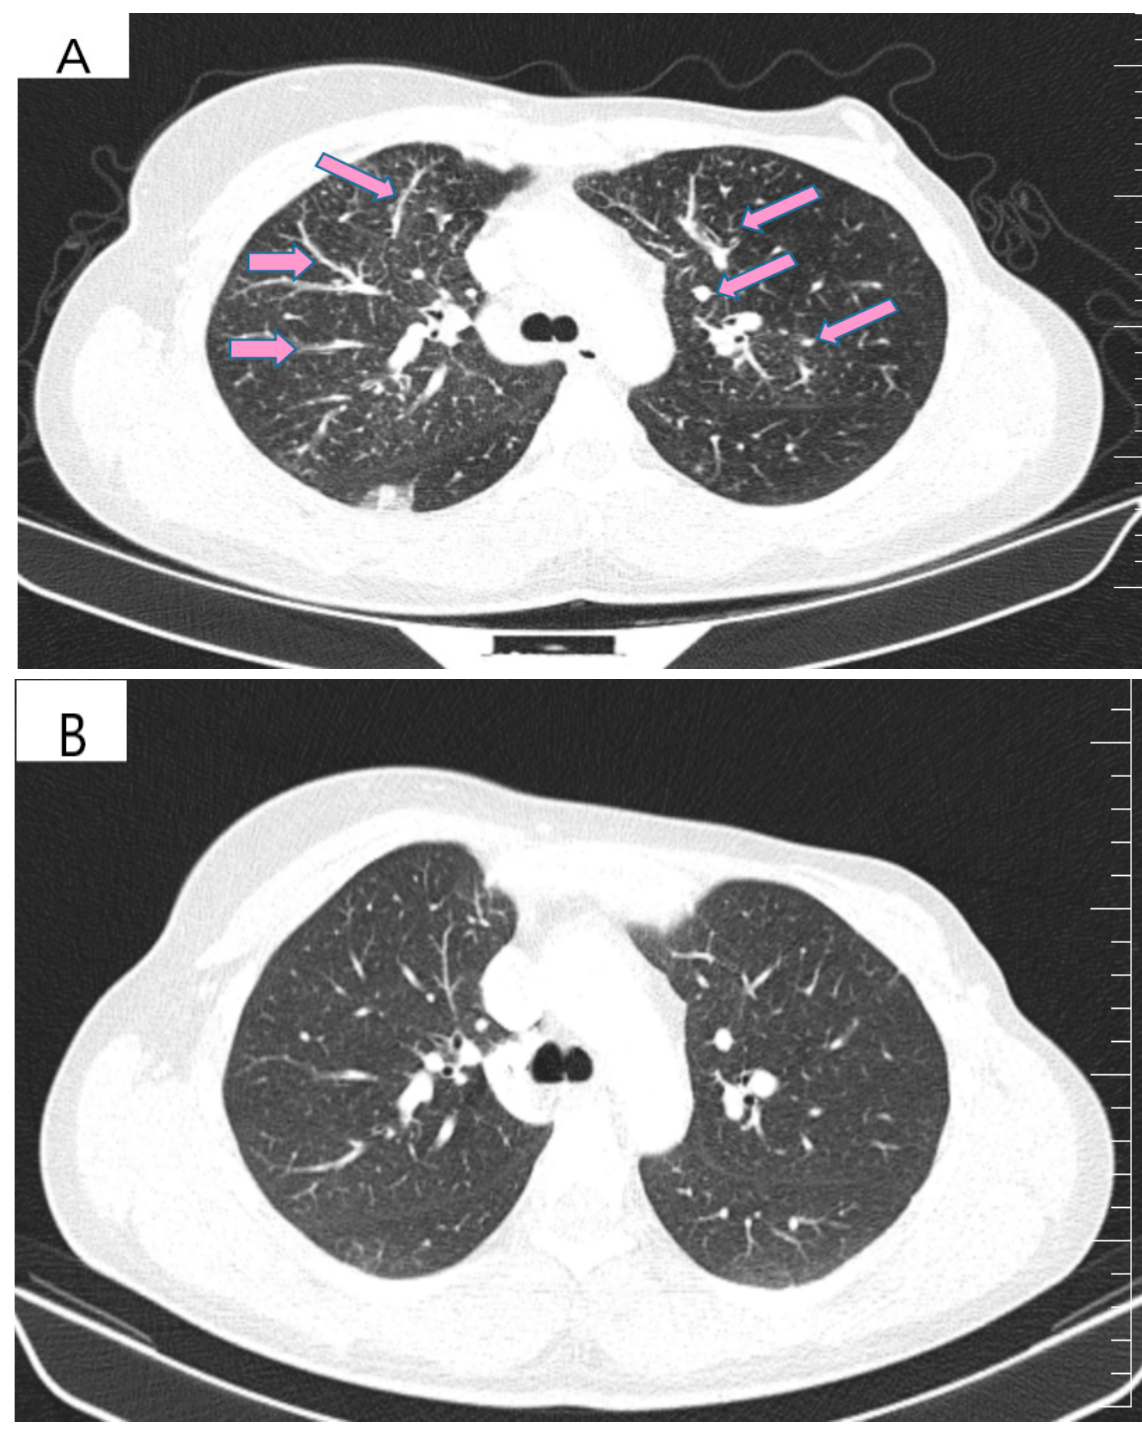
Figure 4. ( A ) Pretreatment CT scan of the lungs showing interlobular septal thickening and multiple bilateral peribronchovascular nodular opacities. ( B ) CT scan showing resolution of interlobular septal thickening and remission of most of the pulmonary nodules after treatment with six cycles of Pertuzumab, Trastuzumab and Paclitaxel.